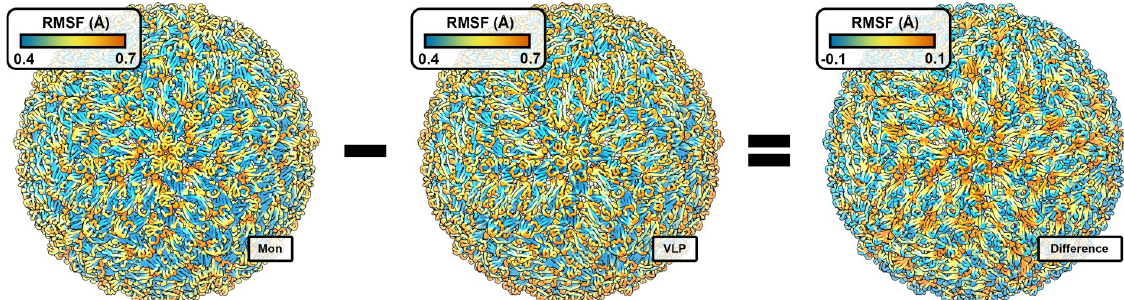
Fig 2. Visualizing the linearly combined, flexibility model via the mature ZIKV cryo-EM reconstruction. From left to right: Weighted isolated protein flexibility, weighted VLP protein flexibility, and the linearly combined, flexibility model are depicted over the mature ZIKV cryo-EM reconstruction (PDB ID: 5IRE) [8] (scales shown). VLP structures are oriented with the five-fold rotational icosahedral symmetry axis coming out of the figure